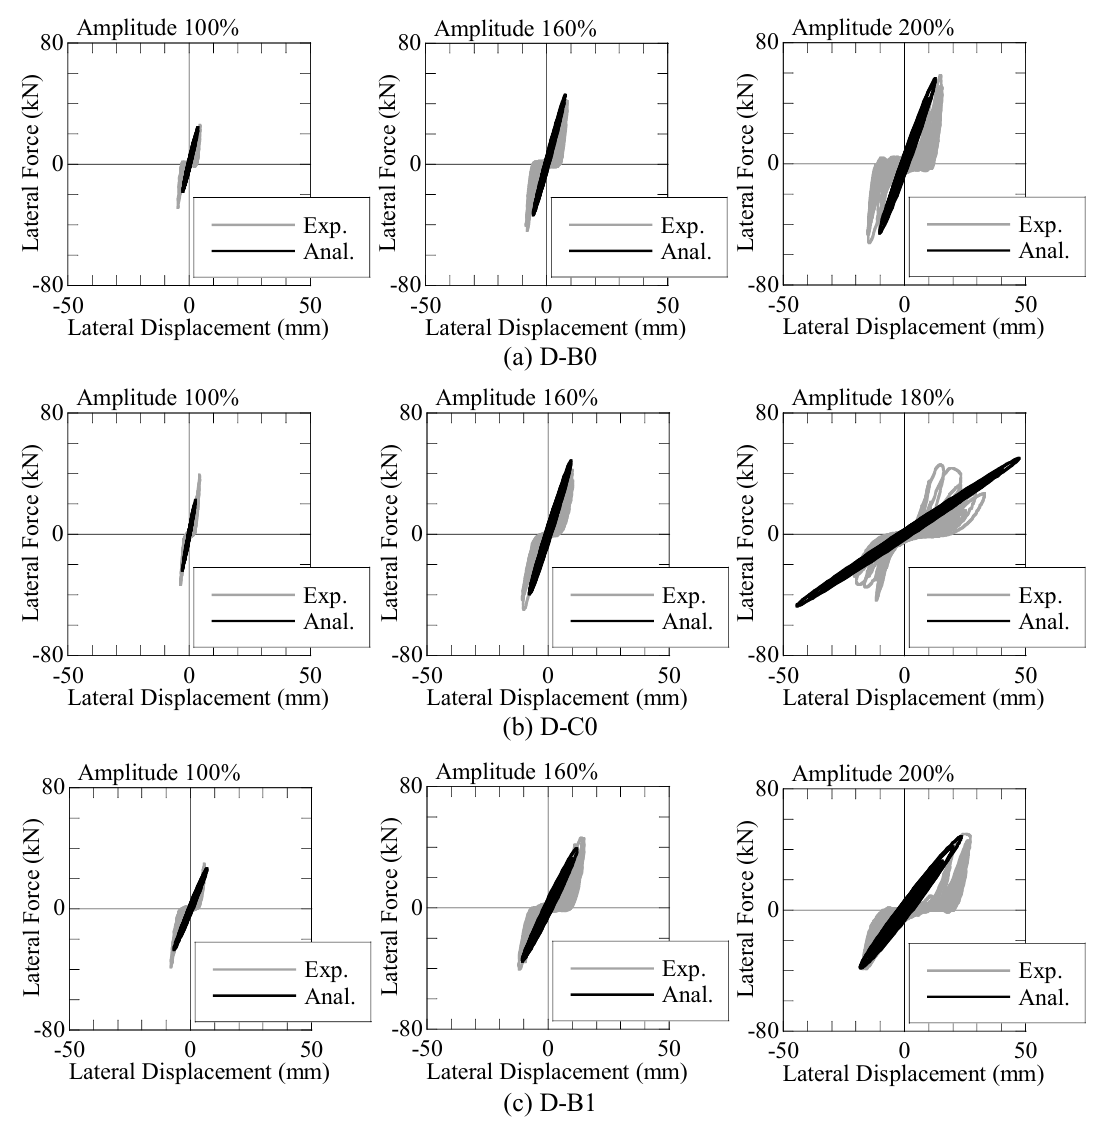
Figure 12. Analytical results based on the linear model.